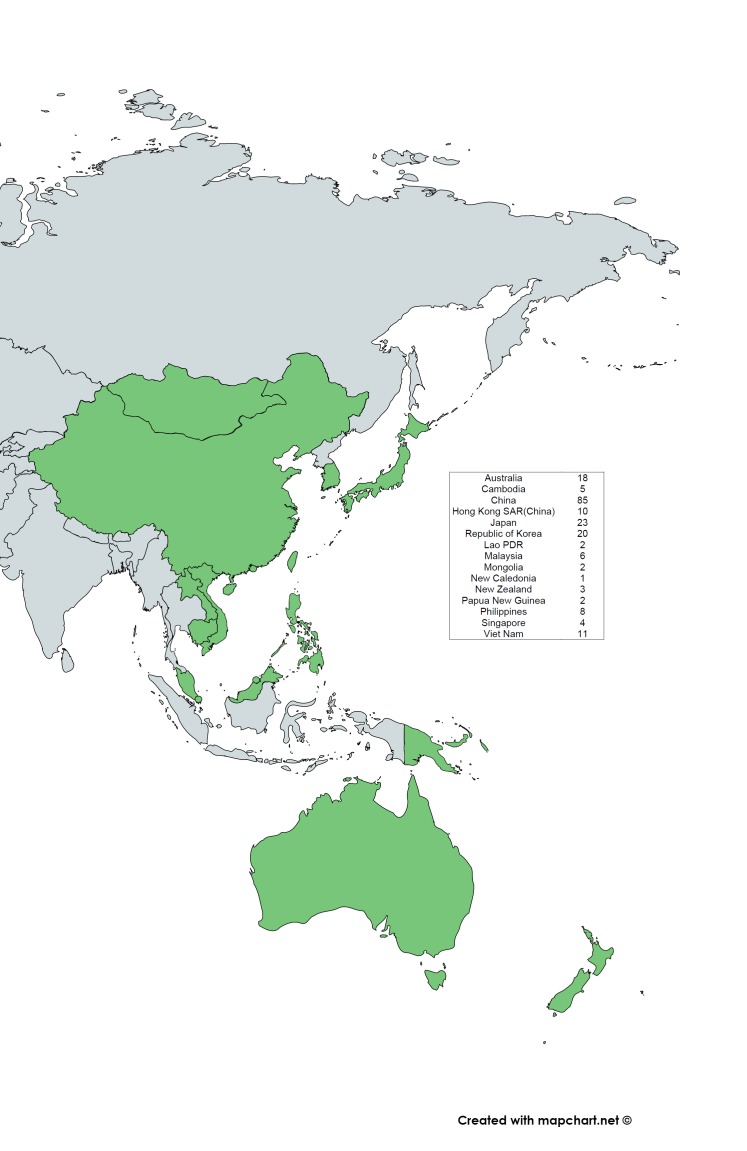
Distribution of respiratory syncytial virus (RSV) studies in 15 of the 37 Western Pacific Region countries/areas. The WPR countries/areas are in green. Map was created with mapchart.net. (Available from: https://mapchart.net/).